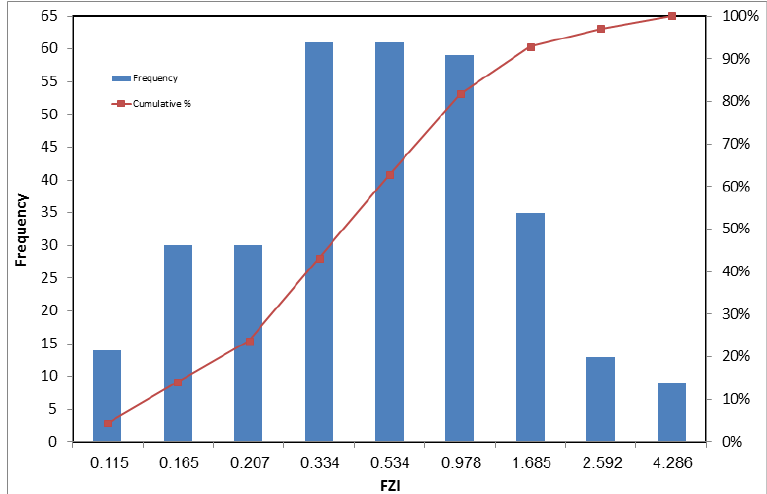
Figure 7. Histogram of flow zone indicator for Upper Bahariya reservoir.